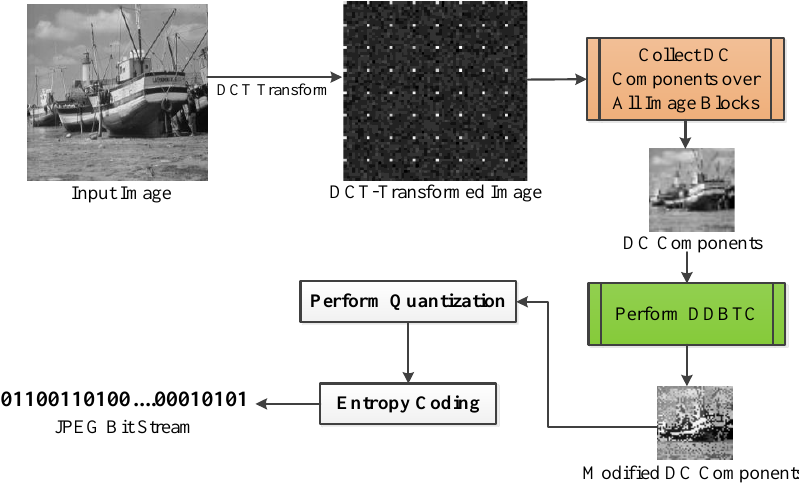
Figure 2. Schematic diagram of the proposed method.